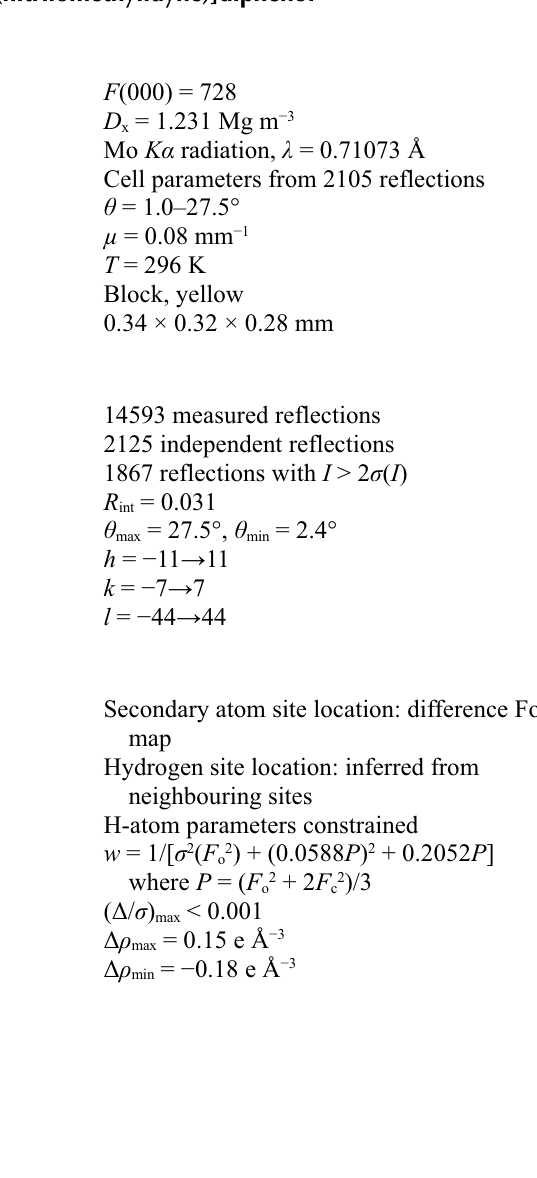
Figure 1 The structure of (I), showing 30% probability displacement ellipsoids and the atom-numbering scheme. 4,4 ′ -Dimethyl-2,2 ′